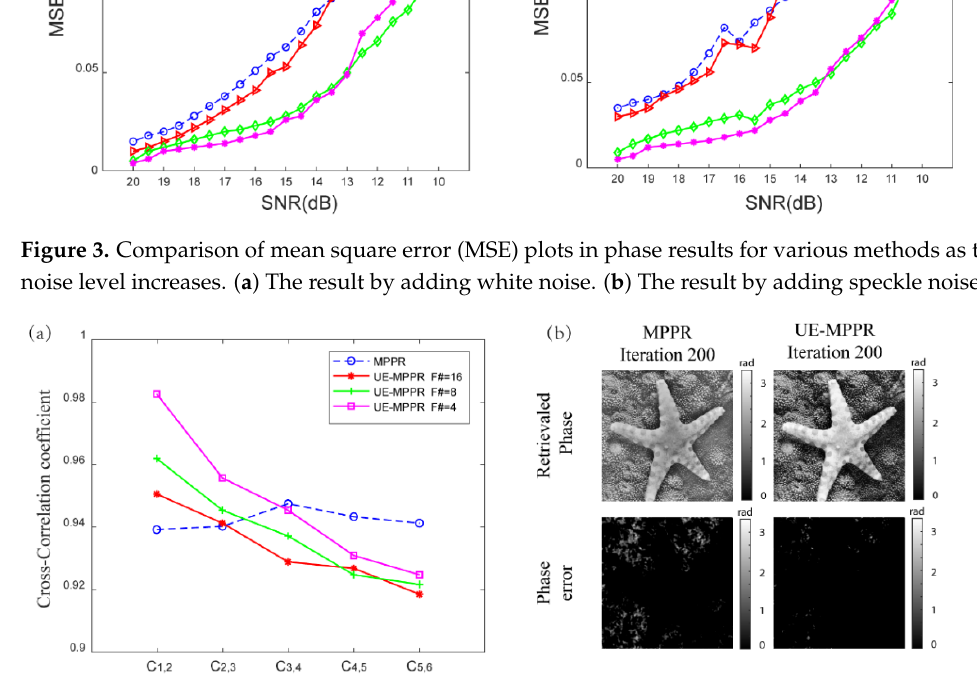
Figure 4. ( a ) The cross-correlation coefficient between the two adjacent planes using MPPR and UE-MPPR, respectively. ( b ) Recovered phase images and their errors compared to the true values by using the conventional MPPR and UE-MPPR methods.